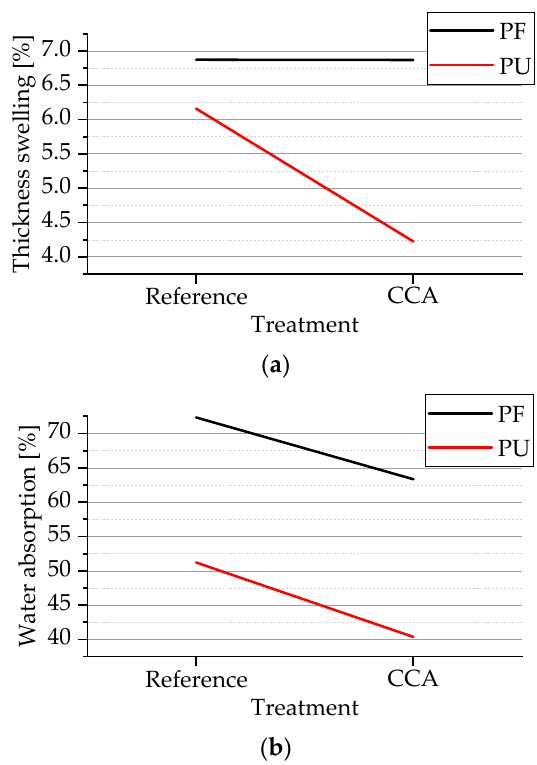
Figure 5. Interaction graphics: ( a ) thickness swelling and ( b ) water absorption. PU panels (T2 and T4) had less thickness swelling than PF panels (T1 and T3) as